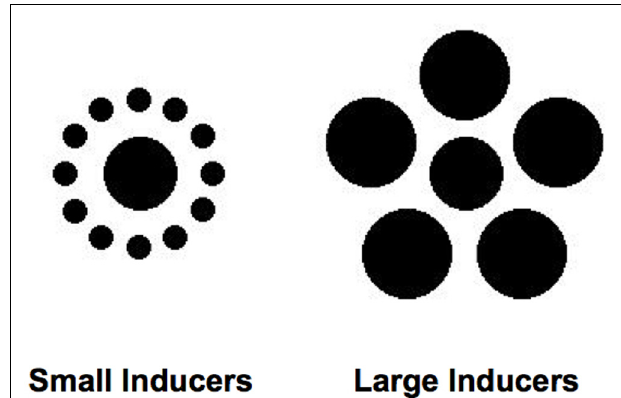
FIGURE 1 | Ebbinghaus–Titchener figures used as stimuli in the experiments. The central dots of the figures are the same physical